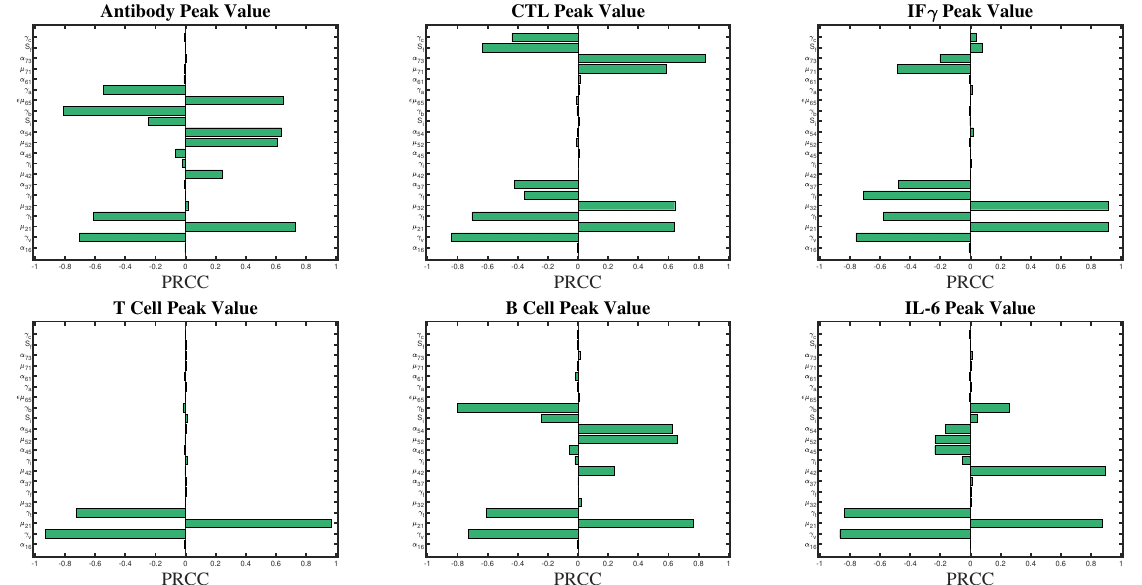
Figure 3. Sensitivity analysis of Model (1) using 10,000 iterations of a Latin hypercube sampling (LHS) method with a partial rank correlation coefficient (PRCC). PRCC values with magnitude close to unity indicate that the parameter has a strong impact on the model output